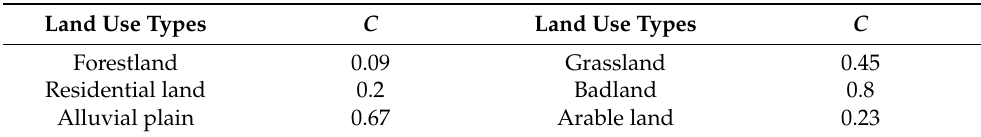
Table 2. C -factor values for different land-use types. Land Use Types C Land Use Types C Forestland 0.09 Grassland 0.45 Residential land 0.2 Badland 0.8 Alluvial plain 0.67 Arable land